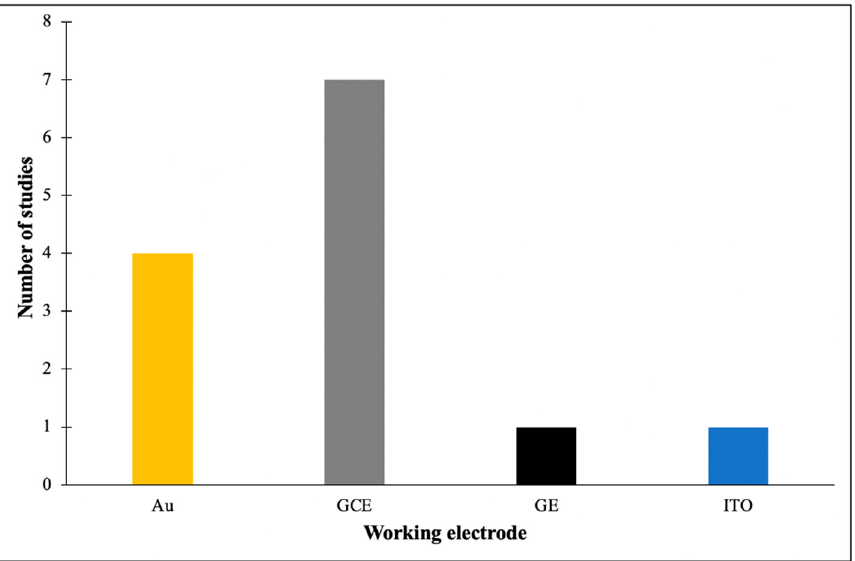
Figure 3. The type of working electrode employed in the fabrication of electrochemical aptasensors for detection of Salmonella. Au = Gold; GCE = Glassy carbon electrode; GE = graphite electrode; ITO = indium tin oxide. Table 3. Type of nanomaterials utilized as a surface modifier of the working electrode.